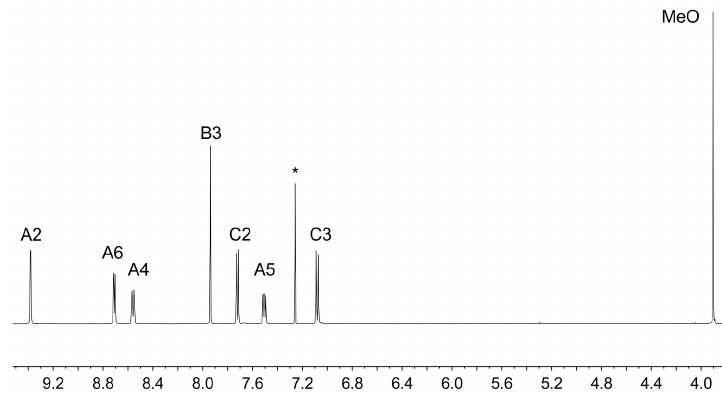
Figure 1. 500 1 H MHz NMR spectrum of 2 (CDCl 3 , 298 K). * = residual CHCl 3 . See Scheme 2 for atom labelling.